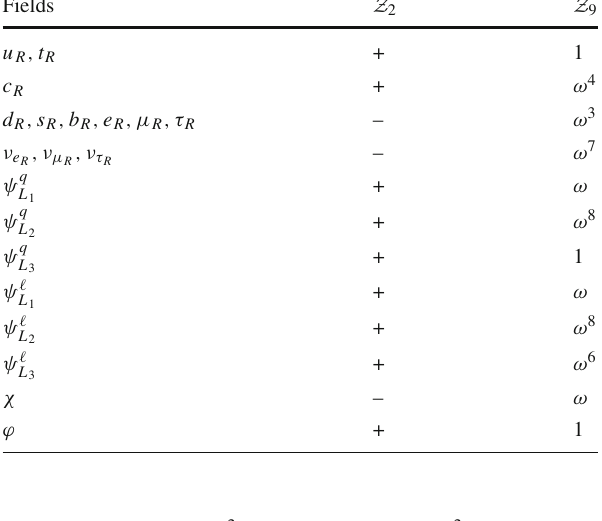
ω is the ninth root of unity